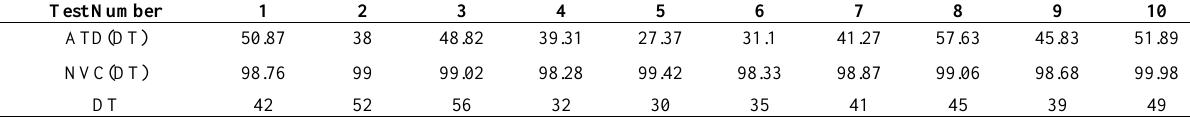
Table 4. Results of ten experiments with scenario 3 (bounded node degree and p=0.7). Test Number